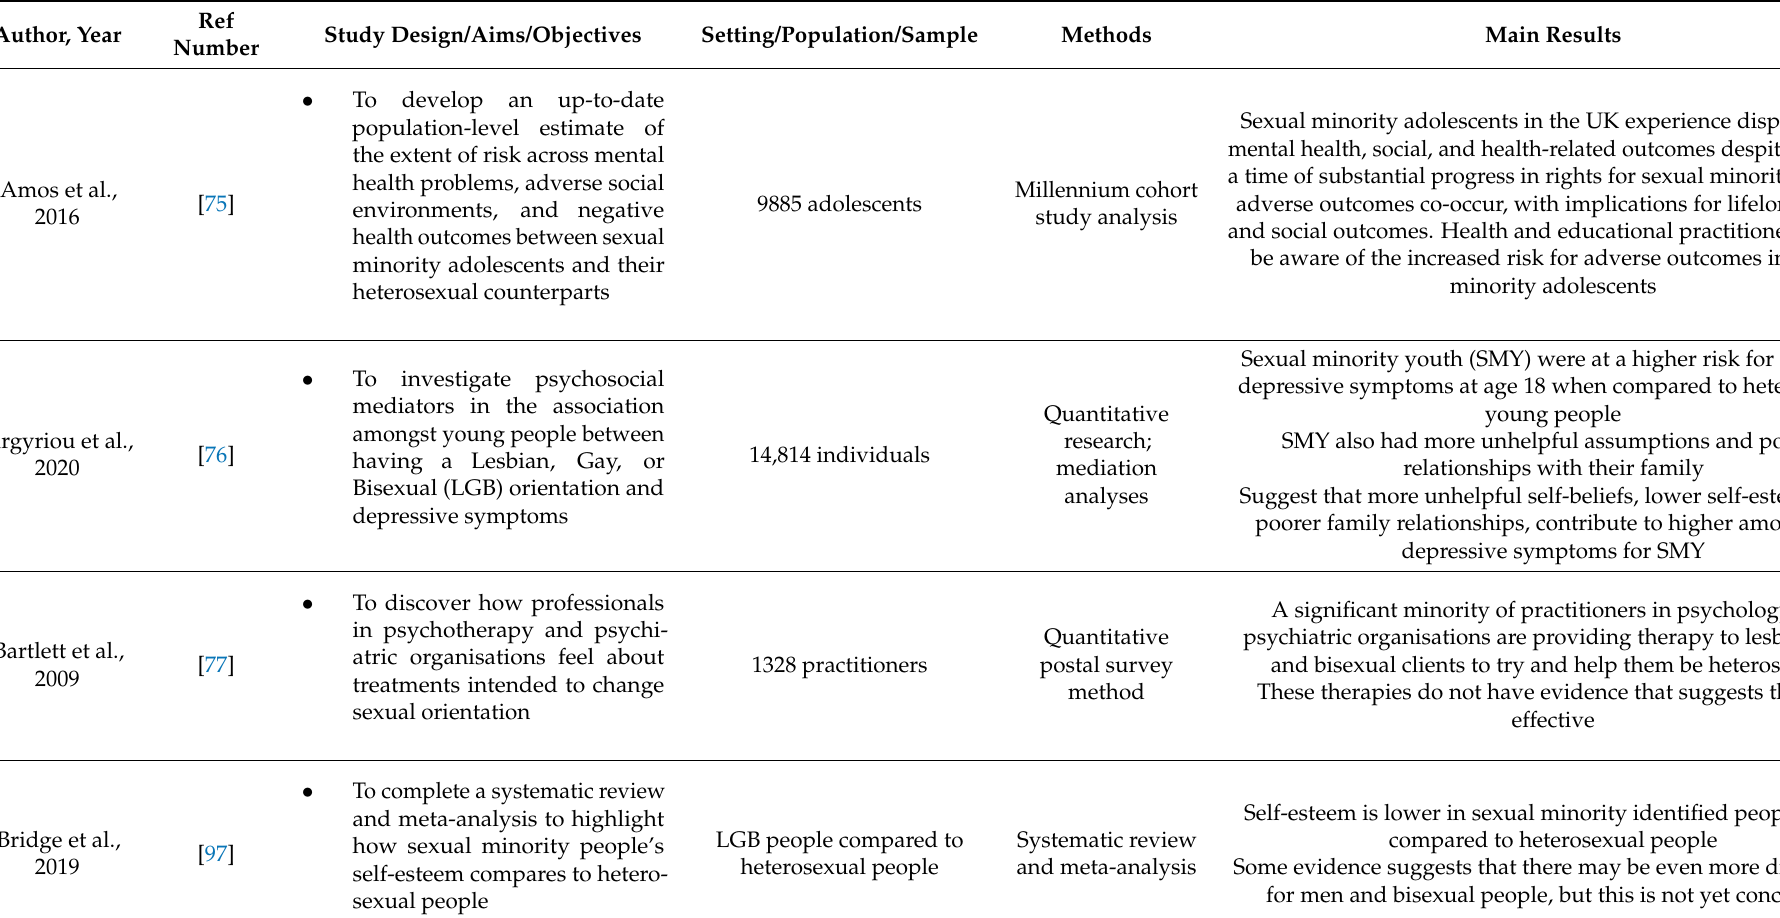
Table A1. Mental Health UK LGBT+